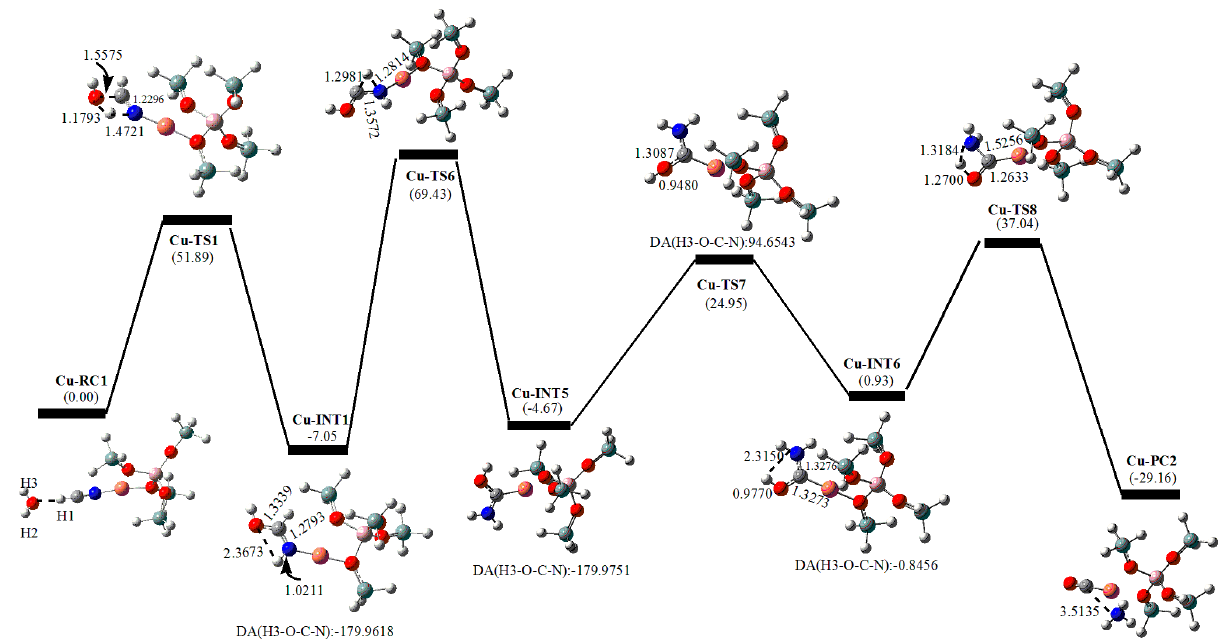
Figure 5. B3LYP/6-31++G (d,p)-optimized structures (in Å) of the stationary points of hydrolysis of HCN with Cu-ZSM5 in the gas phase for path B. The values correspond to the relative free energy ( ∆ G) in kcal/mol with respect to the separate reactants.